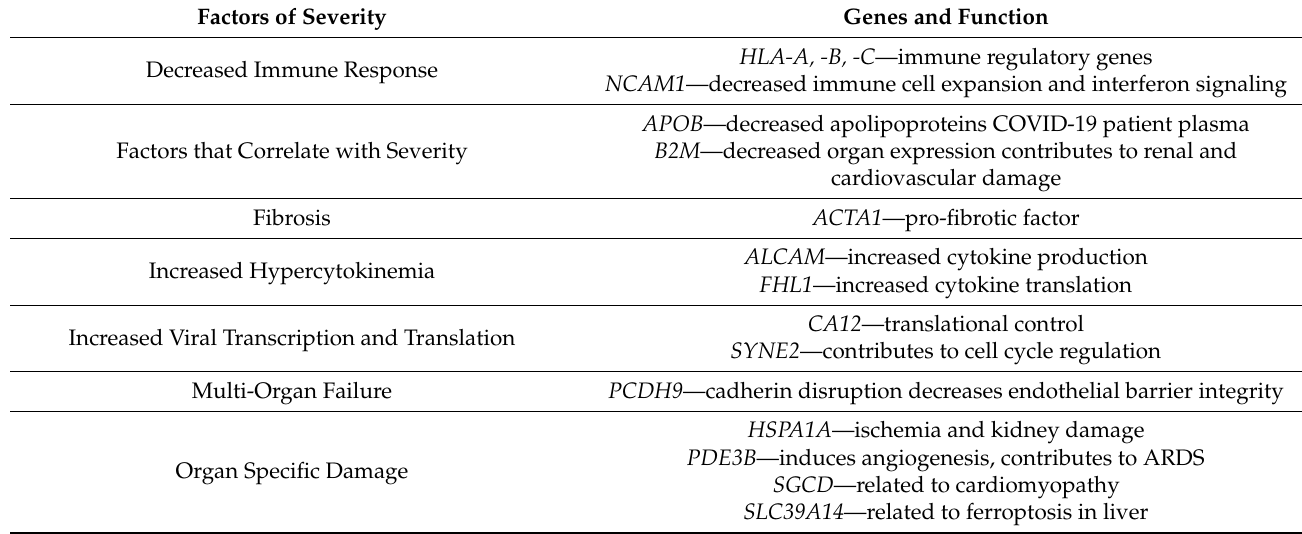
Table 2. Genes and Their Role in Severity. A list of the top genes and their function in disease